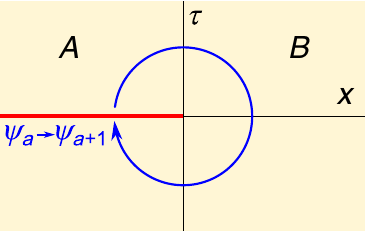
FIG. 2. Replica method for calculating the bipartite entangle- ment entropy, illustrated for spatial dimension D ¼ 1 . To ρ n calculate Tr (cid:3) in the Euclidean path integral formalism, n A ½ A replicas of the original system are introduced. This quantity can then be calculated as the partition function defined on an n - sheeted Riemann surface, constructed as follows: for region A , each replica (with label a ) at time τ ¼ − ϵ is glued to the next replica (with label a þ 1 mod n ) at time τ ¼ þ ϵ ; for region B , each replica is glued back to itself.